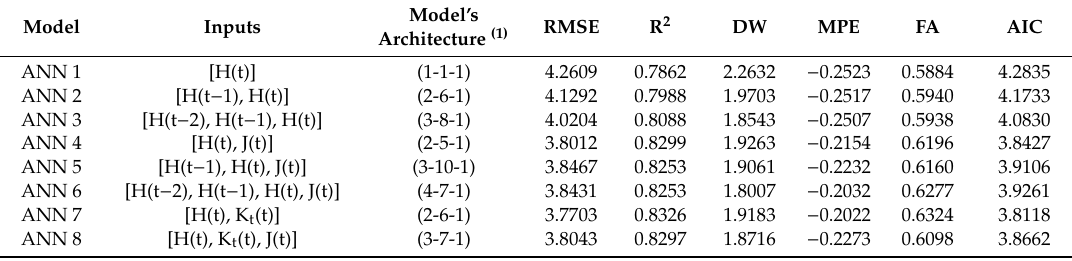
Table 1. Fitting achieved with the eight evaluated ANN models, between simulated values of horizontal daily solar irradiation the day after and measured values during 2011 at the agrometeorological station in Mansilla Mayor (Le ó n, Spain), considering in each model the hidden layer architecture that achieved the best predictions.